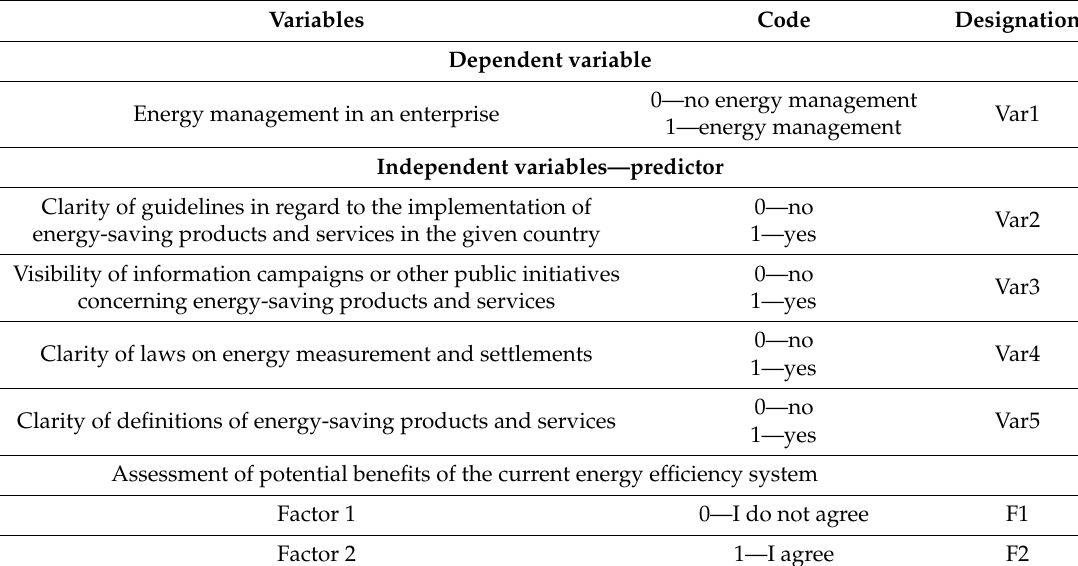
Table 7. Input variables for the logistic regression